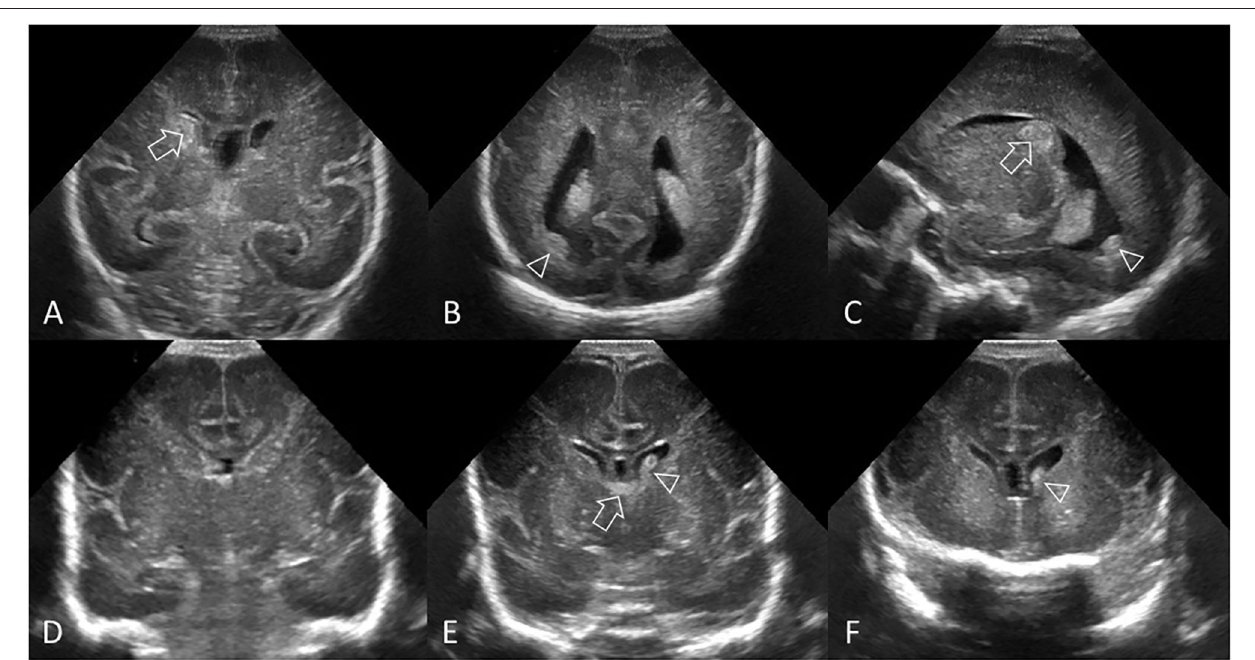
FIGURE 3 | Grade II GMH-IVH. (A–C) Ultrasound scan in a preterm infant (GA 26 weeks) with common pattern of grade II GMH-IVH. (A) Coronal scan at the level of the frontal horns of the lateral ventricles shows echogenic clot involving the caudate nucleus (arrow). No ventricular dilatation. (B) Coronal scan at the level of the trigone of the lateral ventricles shows a small volume of intraventricular clot layering dependently (arrowhead). (C) Parasagittal scan through the right lateral ventricle shows the same clot centered at the caudothalamic notch (arrow) and the intraventricular hemorrhage within the occipital horn separate to choroid plexus (arrowhead). (D–F) Ultrasound scan in a different preterm infant (GA 27 weeks) with delayed pattern of Grade II GMH-IVH. (D) Coronal scan, at the level of the frontal horns of the lateral ventricles, was initially normal 2 days after birth. No GMH-IVH was detected. (E) Follow-up coronal scan 6 days after birth shows echogenic clot in the left lateral ventricle (arrowhead). The AHW is < 6mm (measurement not shown). Normal choroid plexus in the roof of the third ventricle (arrow). (F) Additional coronal view of the frontal horns anterior to the foramen of Monro shows further echogenic intraventricular clot (arrowhead). There is no extension of choroid plexus anteriorly past the caudothalamic grooves (i.e., the frontal and occipital horns have no choroid plexus), thus echogenic material in these sites suggests IVH. This infant had two cUS exams in the first week after birth. The cUS scan showing the greatest severity of GMH-IVH in the first week (i.e., cUS at 6 days after birth in this case) should be considered for GMH-IVH classification purposes.